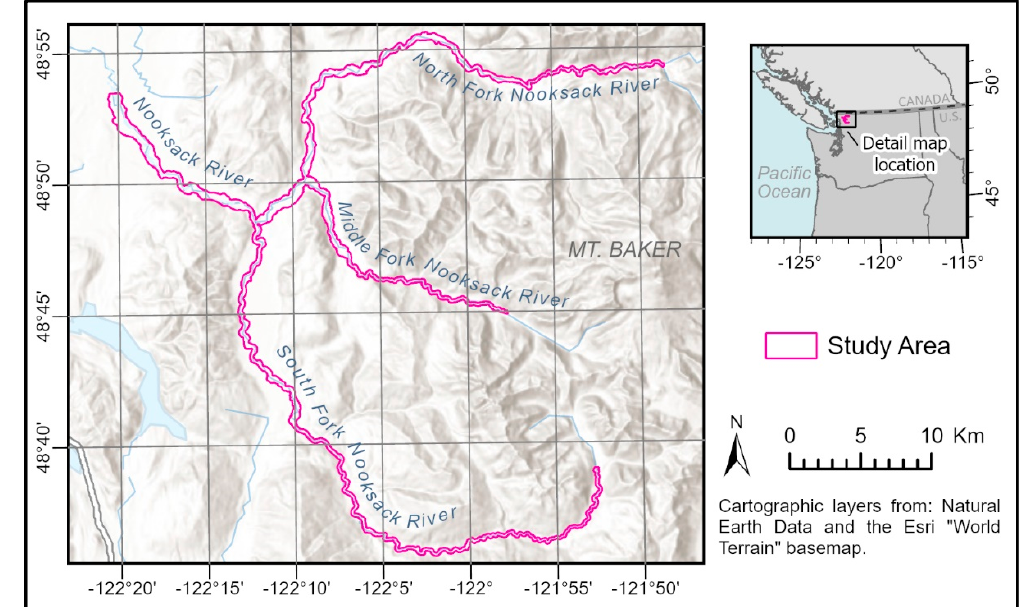
Figure 1. Map of the study area along the Nooksack River, Washington, USA.